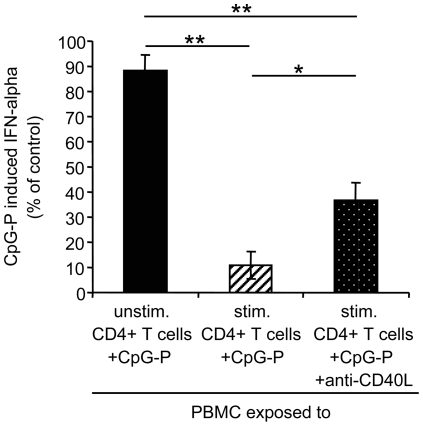
Effect of CD40L neutralization on the suppression of CpG-P induced interferon (IFN)-alpha production.Peripheral blood mononuclear cells (PBMC) of three control donors were preincubated with 50,000 unstimulated (unstim.) or PMA/ionomycin-stimulated (stim.) CD4+ T cells of the respective donors for 48 hours, in the absence or presence of a cell-culture grade anti-CD40L antibody (30 µg/ml), and then stimulated with CpG-P 21798 (0.25 µM) for additional 24 hours. Data are presented as mean and standard error. *p<0.05, **p<0.01 (Tukey HSD test).